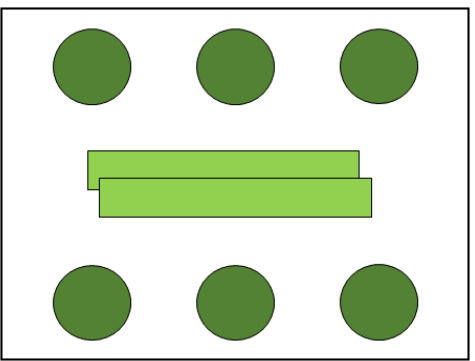
Figure 2. Six strawberry leaf discs (2 cm diameter) with two leaf rectangles (8 cm × 1 cm) of the aromatic plant in a box (11 cm × 11 cm × 3.5 cm), for the Tetranychus urticae oviposition and longevity